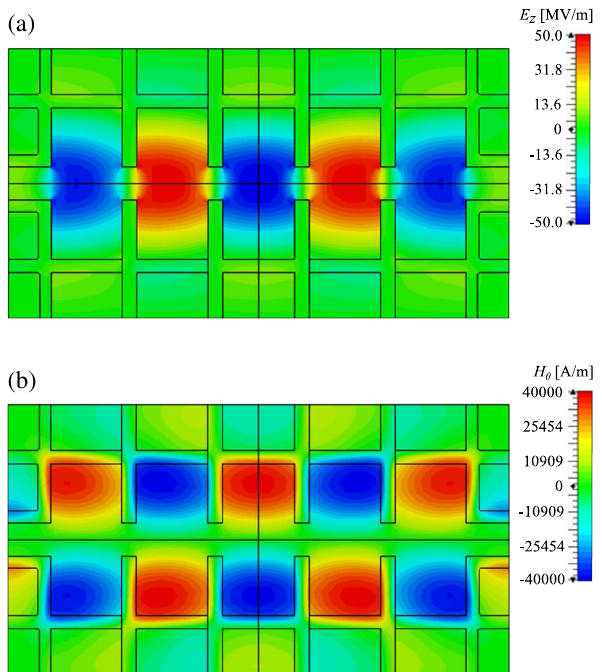
FIG. 14. Magnitude of (a) the longitudinal electric field dis- tribution and (b) the rotating magnetic field distribution in the optimized DAA structure. The longitudinal cross section of the DAA structure is shown. This field intensity is shown in arbitrary